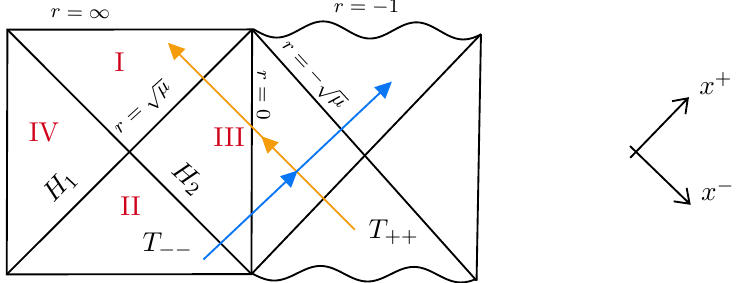
Figure 1 . The yellow line corresponds to a pulse of shockwave coming out from the past black hole horizon and falling into the future cosmological horizon. The blue line corresponds to a pulse of shockwave falling from the past Cosmological horizon to the future black hole